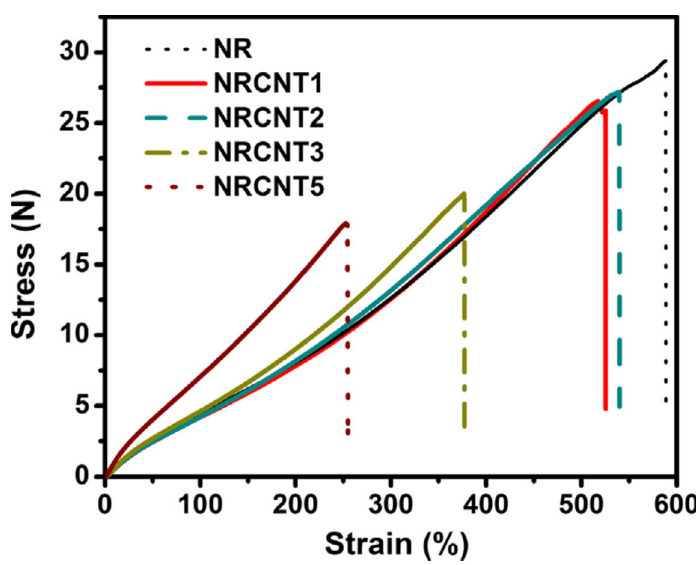
Figure 1. Stress-strain curves for pure NR and NR/multiwall carbon nanotubes (MWCNT) composites. Reproduced with permission from Elsevier [23].